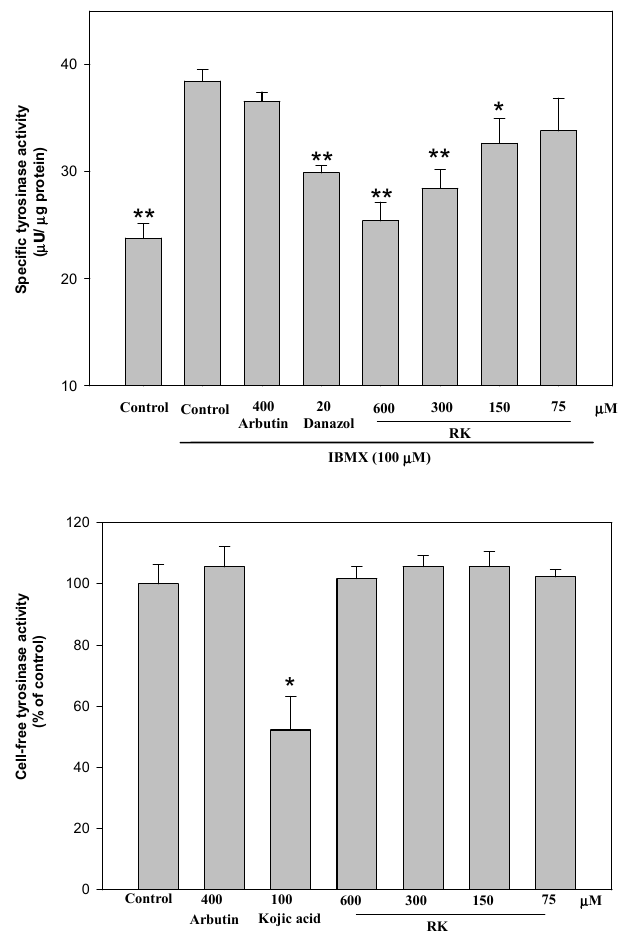
Figure 3. Effects of RK on Cellular ( A ) and Cell-free ( B ) Tyrosinase Activity in B16 Cells. Tyrosinase activity was determined by spectrometry, using L -DOPA as a substrate, as described in the Experimental Section. For the assay of cellular tyrosinase activity (A), B16 cells were cultivated for 1 d and then stimulated with 100 µM of IBMX for 2 d with various concentrations of RK. At the end of the drug treatment, the cells were harvested and assayed for the cellular tyrosinase activity by adding the enzyme substrate. For the assay of cell-free tyrosinase activity (B), untreated cells were lysed to obtain a crude tyrosinase extract. The cell-free tyrosinase activity was determined by directly mixing the crude tyrosinase, L -DOPA, and various concentrations of RK. Averaged data (n = 3) are presented with error bars indicating SD. A value of p < 0.05 (*) or p < 0.001 (**), obtained with a Student’s t -test by comparing the data with those for the IBMX-stimulated control (A) or control (B), was considered statistically